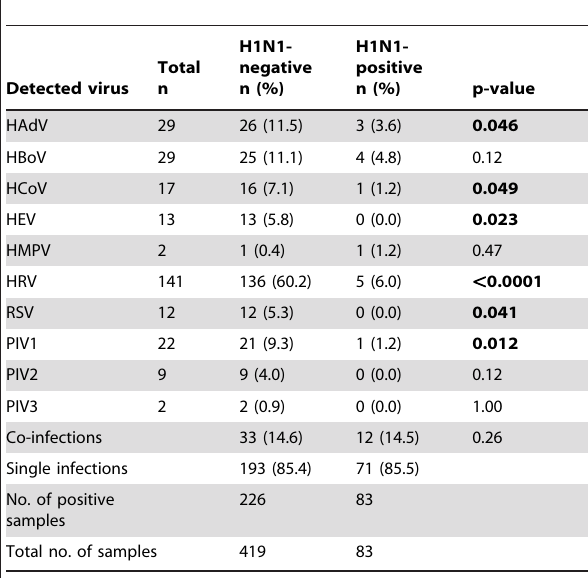
Table 2. Distribution of virus in H1N1-positive and H1N1- negative samples.